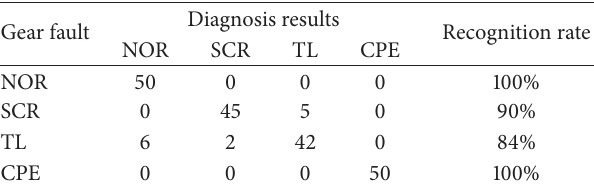
Table 2: Classification results with proposed method